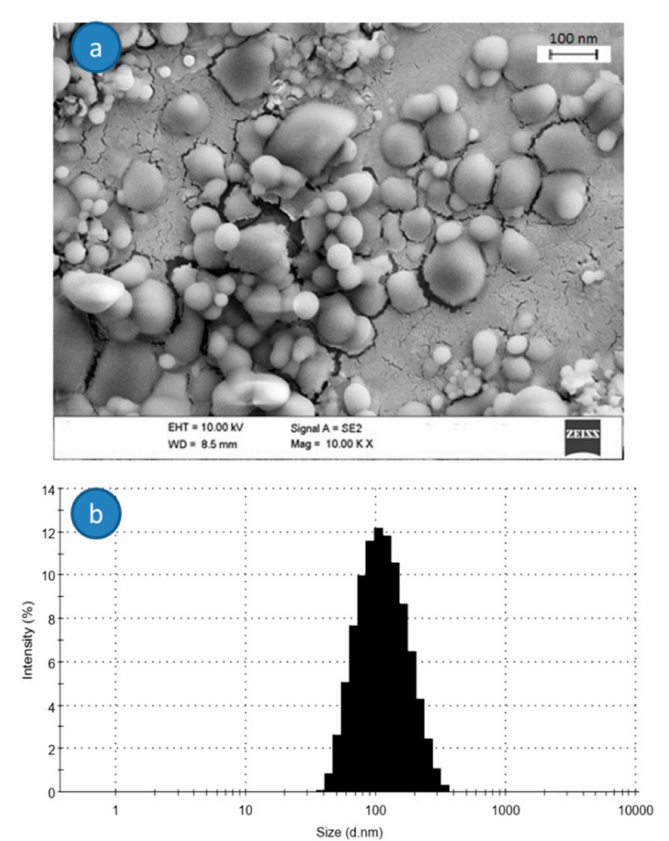
Figure 1. SEM micrograph ( a ) and particle size distribution ( b ) of freeze-dried CNPs.